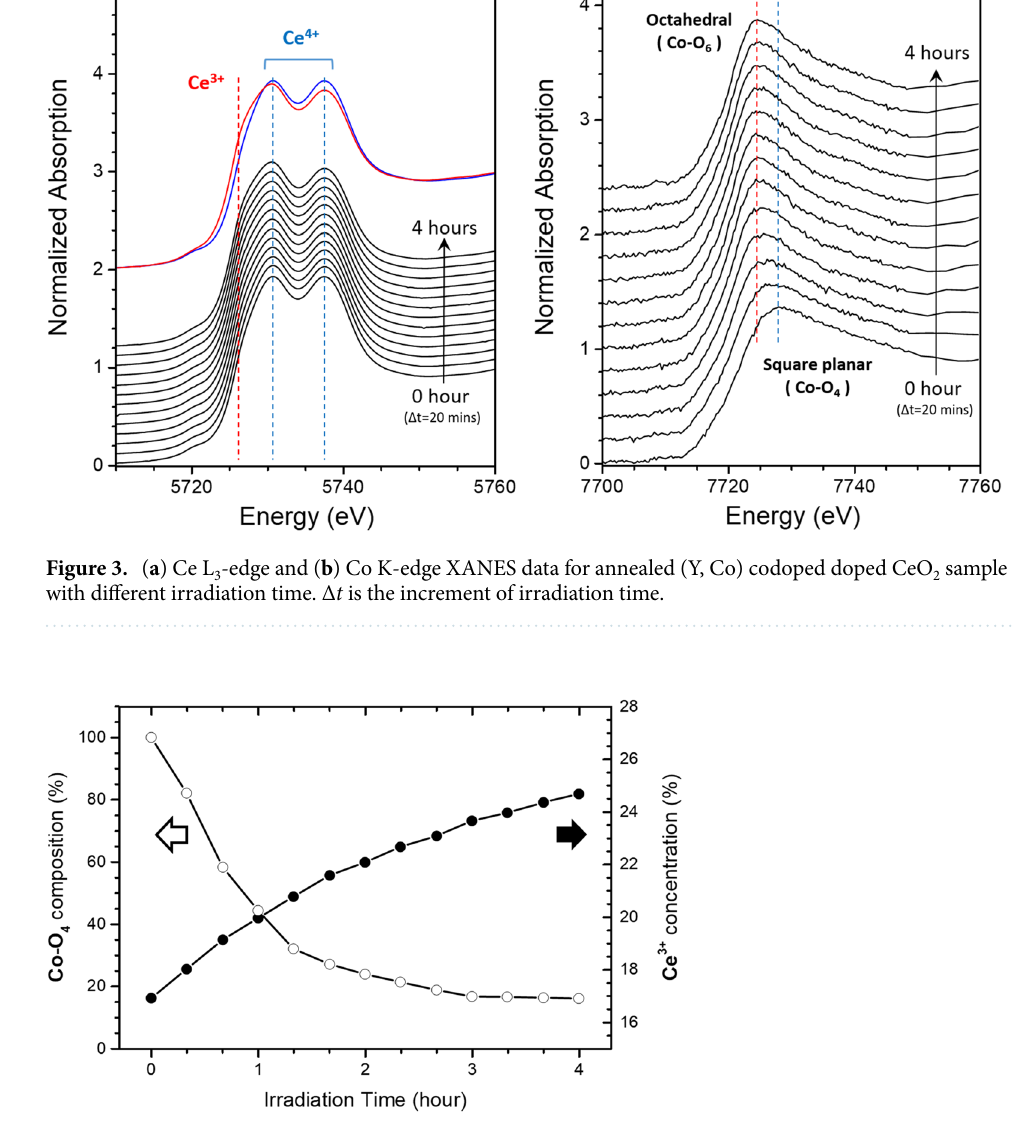
Figure 4. Plot of Ce 3+ concentration and Co-O4 composition vs. irradiation